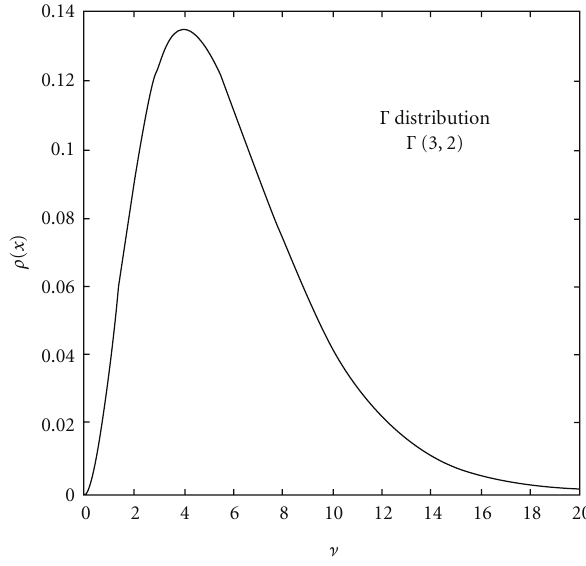
Figure 6: Gamma distribution: Γ